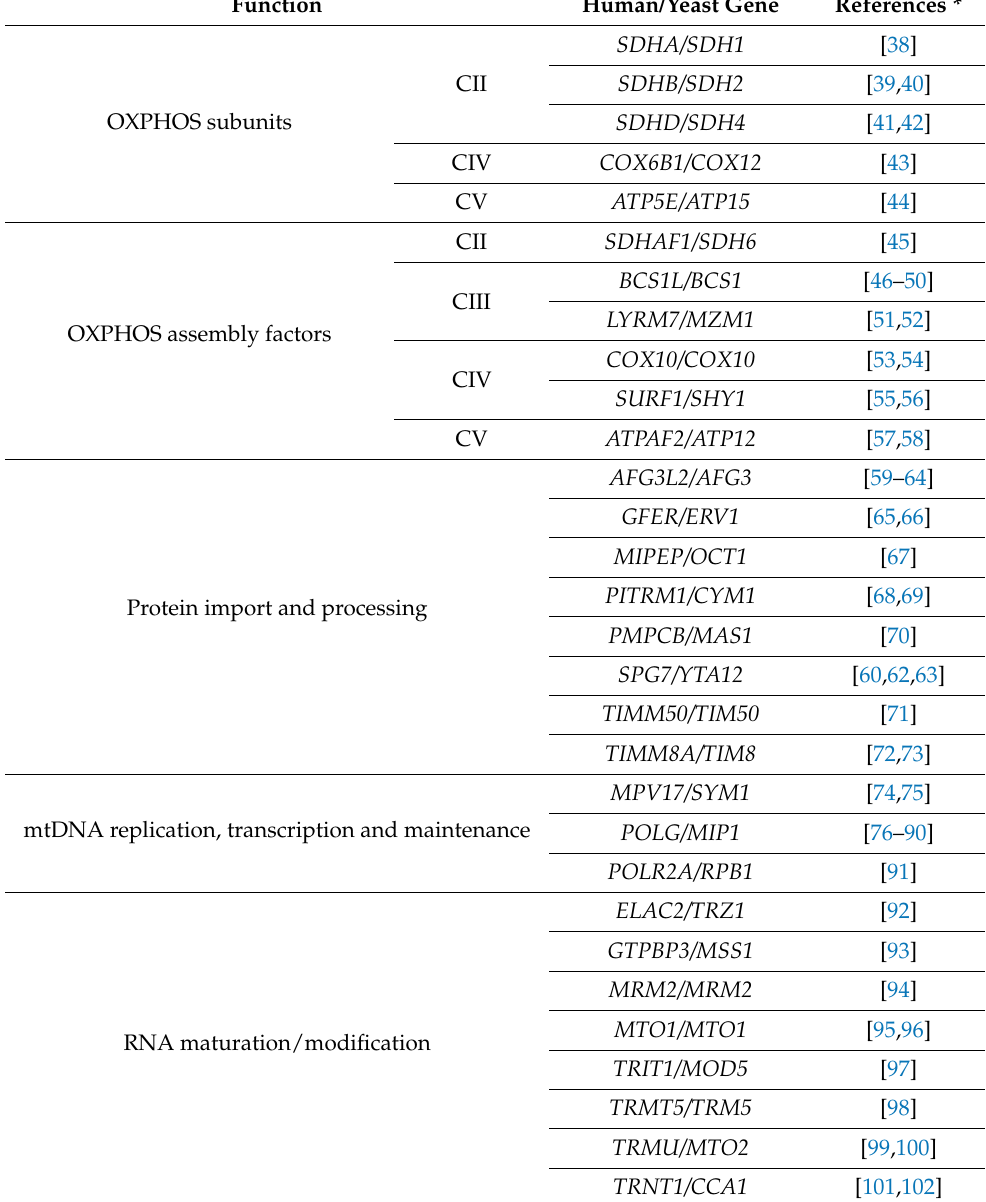
Table 1. List of genes linked to mitochondrial diseases categorised according to their primary role. This table includes nuclear genes associated to mitochondrial disorders in humans with an orthologous gene in S. cerevisiae * for whom the yeast model was reported in the literature to have been used to validate the pathogenic role of the variants associated with